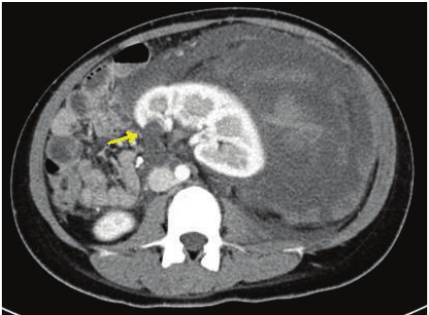
Figure 5: Cystic lesion in left kidney upper pole is clearly visible and marked with yellow